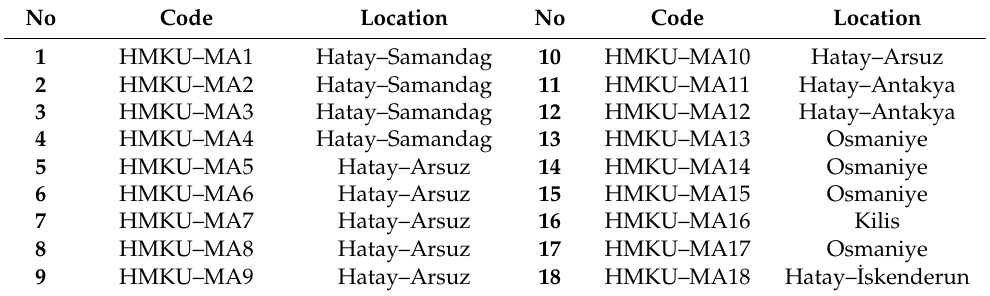
Table 1. Genotype codes and